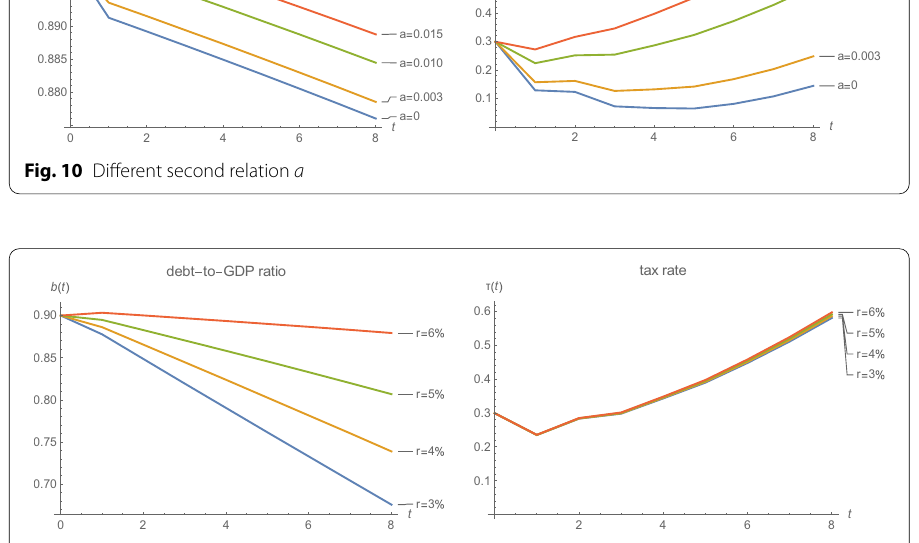
Fig. 11 Different interest rate